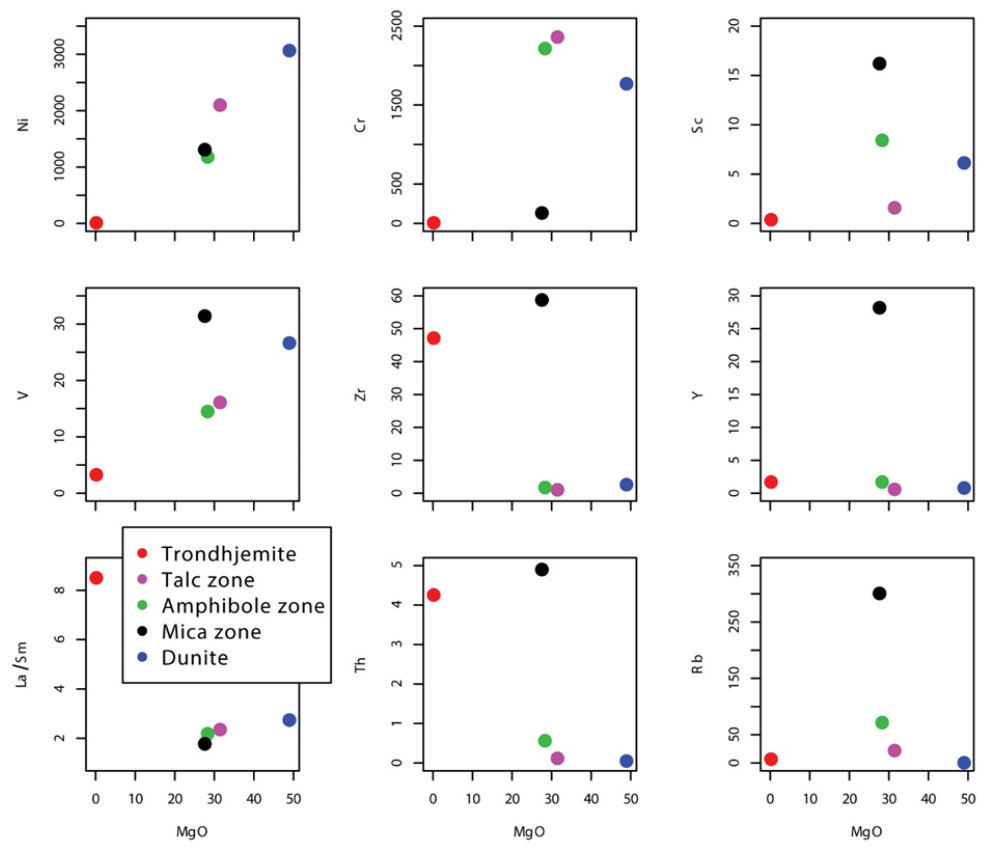
Figure 8. Trace elements plotted against MgO contents for the samples of this study. Like for the major elements shown in Figure 7, the three metasomatic zone roughly fall on a trend between the dunite and trondhjemite as the endmembers. The mica zone show deviation by having elevated Sc, V, Zr, Y, Th, and Rb. All traces elements are given in ppm.